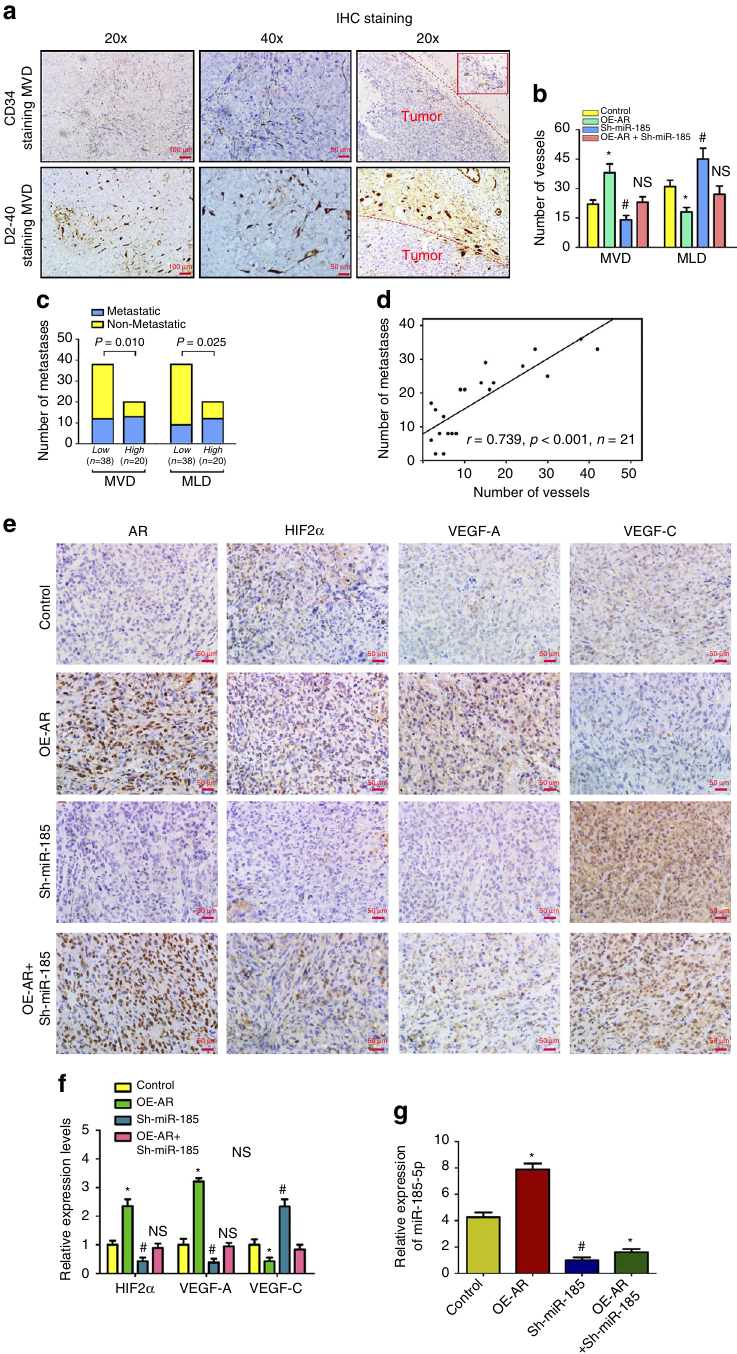
Fig. 8 AR in fl uences MVD and MLD by regulating VEGF-A and VEGF-C. After the mice were killed, the primary tumor tissues were fi xed with 4% formaldehyde, imbedded in paraf fi n and processed by immunohistochemistry. a Representatives images of IHC staining of CD34 for microvessel density (MVD) and D2-40 for microvessel lymphatic density (MLD) inside or surrounding primary tumors, respectively. Dashed lines mark the borders between tumor nodules and surrounding tissues. Scale bars in 20× and 40× represent 100 and 50 μ m, respectively. b Quantitation of angiogenic and lymphangiogenic vessels (MVD vs. MLD) in the various groups (four mice/group). Mean ± SEM of fi ve random views was calculated for every slide and group. c Metastatic possibility was strati fi ed by low-level (~2/3, N = 38) or high-level (~1/3, n = 20) of MVD/MLD ( χ 2 -test). d Number of metastatic nodules in lung and/or liver was positively correlated with MVD (linear correlation, r = 0.739, p < 0.001, n = 21). e Representative picture of IHC staining of AR, HIF2 α , VEGF-A, and VEGF-C in the primary RCC. Overexpression of AR increased VEGF-A expression while suppressed VEGF-C expression, but knockdown of miR-185-5p could reverse the results of AR. Scale bars , 50 μ m. f Quantitation of HIF2 α , VEGF-A, and VEGF-C expressions detected by immunohistochemistry using Image-Pro Plus software (four mice in every group). g Real-time PCR assays for miR-185-5p expression in various groups. Total RNAs were subjected to real-time PCR assays and the relative expressions were plotted as distribution plots. The experiments were carried out in triplicate. *and # p < 0.05 were considered statistically signi fi cant. *AR compared to control and # Sh-miR-185-5p compared to control. NS no signi fi